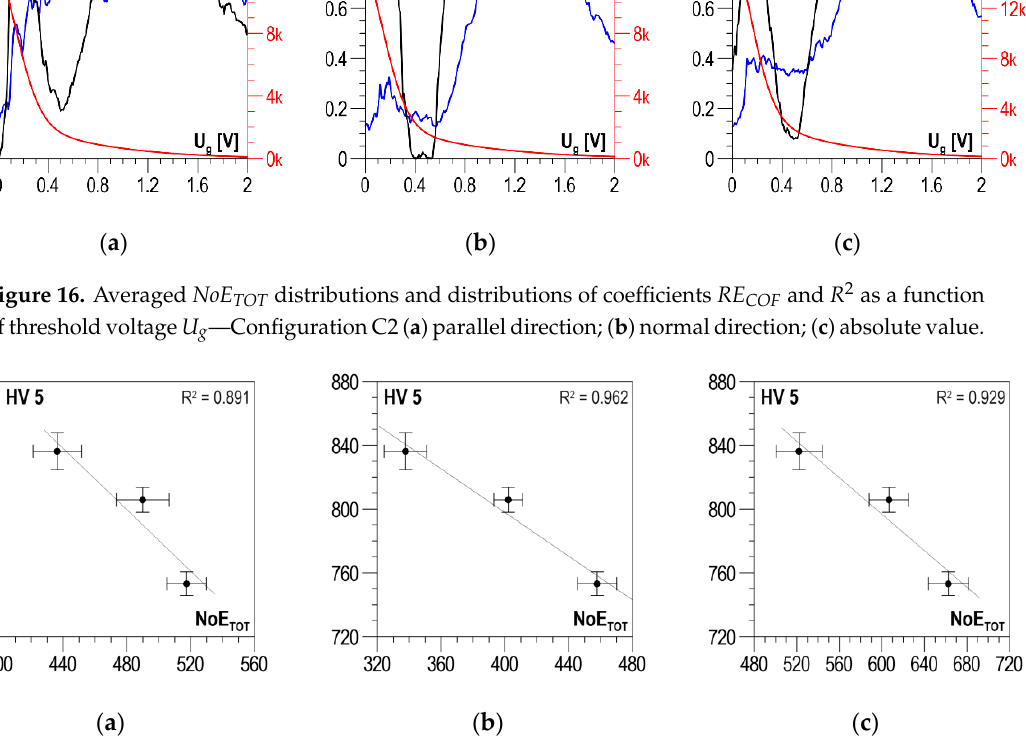
Figure 17. Linear correlations between NoE TOT and HV5 hardness—Configuration C2 ( a ) parallel direction, U g = 1.12 V; ( b ) normal direction, U g = 1.22 V; ( c ) absolute value, U g = 1.19 V.